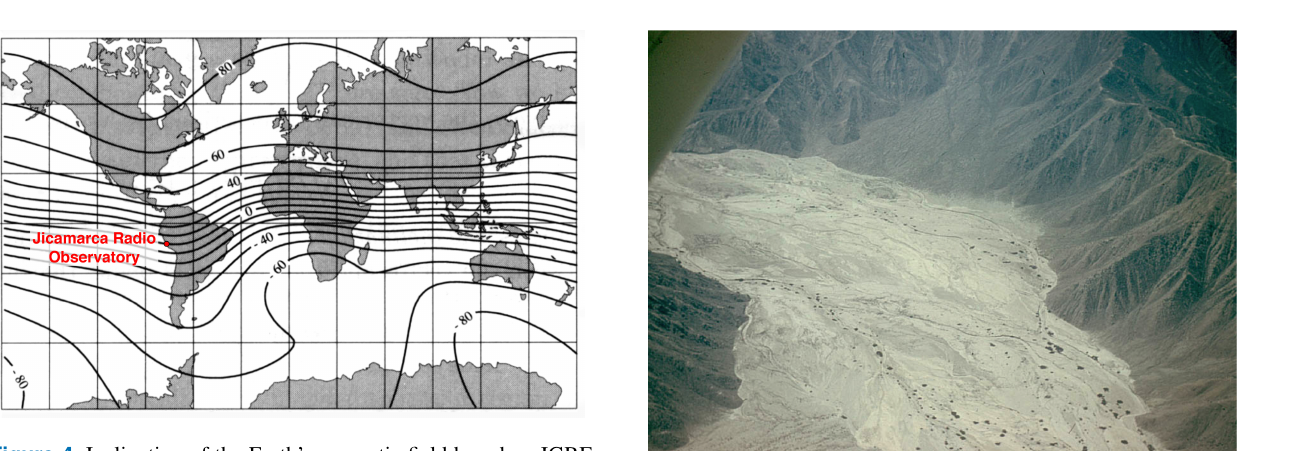
Figure 4. Inclination of the Earth’s magnetic field based on IGRF 1990. The magnetic Equator ( I = 0 ◦ ) passes through the central part of Peru. This fact has remained true since the 1960s until to- day despite the time variation in the magnetic field (adapted from Blakely, 1995).